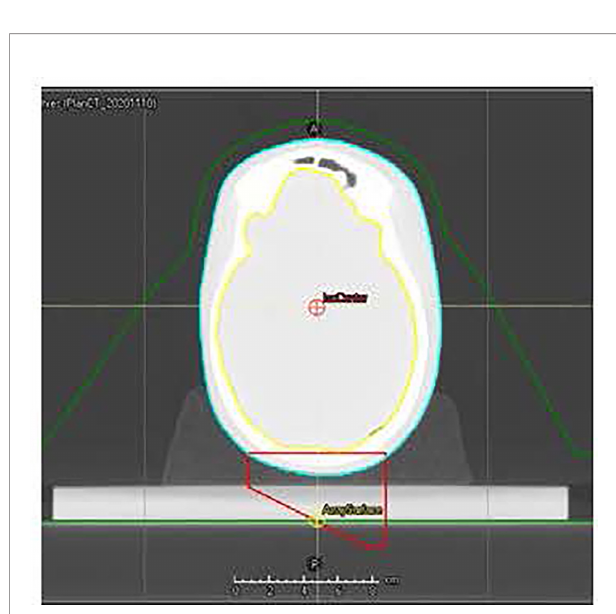
FIGURE 2 | CT image of the head phantom with a wedge-shaped